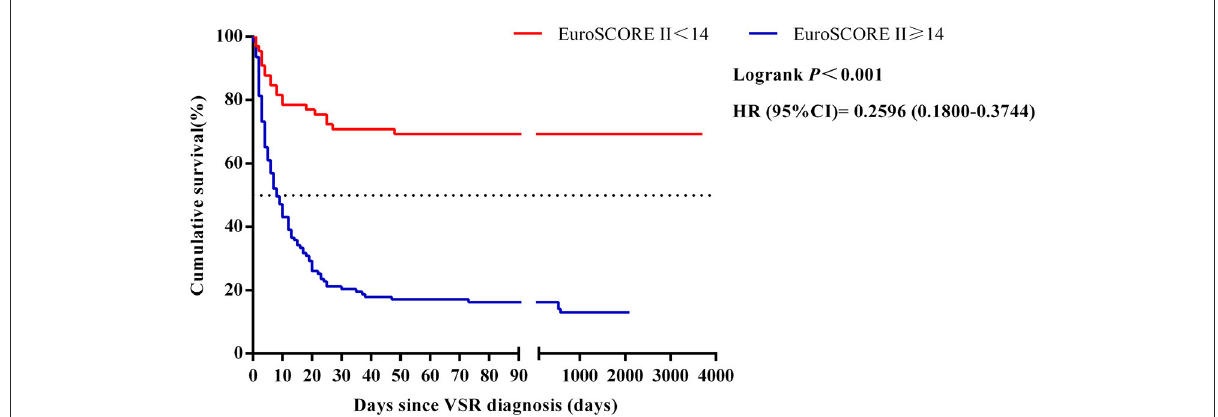
FIGURE4 Relationships between the EuroSCORE II scores and 10-year mortality in patients with VSR. HR, hazard ratio; CI, confidence interval; VSR, ventricular septal